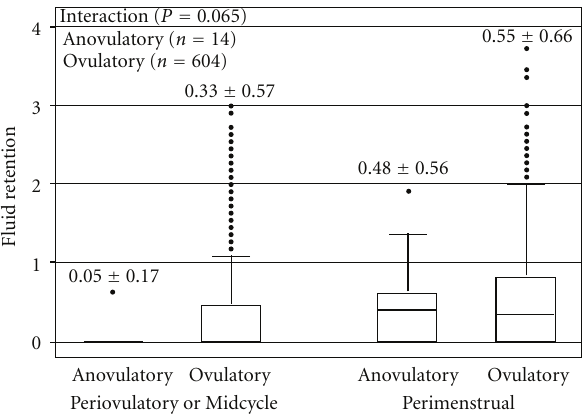
Figure 3: Box plots of fluid retention scores comparing data from anovulatory ( n = 14) and ovulatory ( n = 604) cycles averaged over the 11-day intervals of the periovulatory or mid-cycle window and the perimenstrual windows. Boxes show 25th, median, and 75th percentiles, bars show upper adjacent values, and dots represent outliers beyond that. The mean ± SE are shown above each box plot. Repeated measures analysis of variance found a nonsignificant interaction ( P = 0 . 0645) between ovulatory status and menstrual timing of fluid retention, a significant e ff ect of menstrual timing ( P < 0 . 0001) and no overall e ff ect of ovulation ( P = 0 . 546). Data were collected by 62 initially ovulatory women over one year. Fluid retention/“bloating” was scored from 0–4 using daily Menstrual Cycle Diary